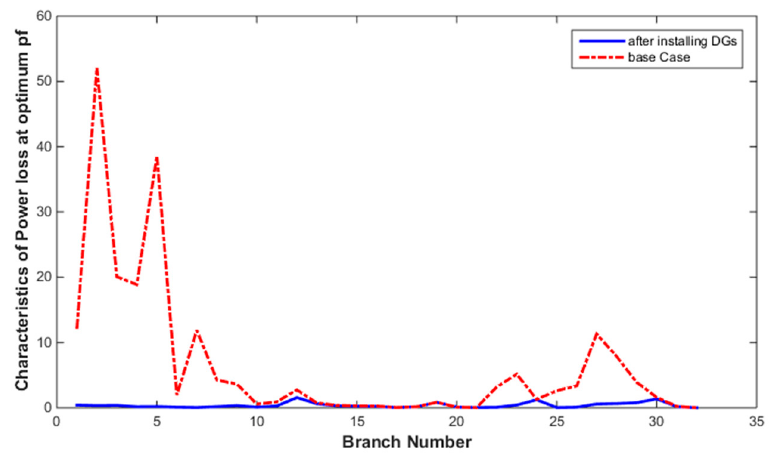
Energies 2020 , 13 , x FOR PEER REVIEW Figure 17. Characteristics of power loss, 33-bus system at optimum pf. Figure 17. Characteristics of power loss, 33-bus system at optimum pf.